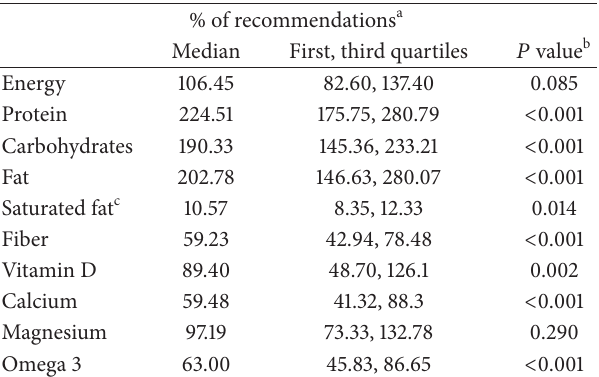
Table 1: Nutrient intakes expressed as percentage of recommenda- tion by gender and